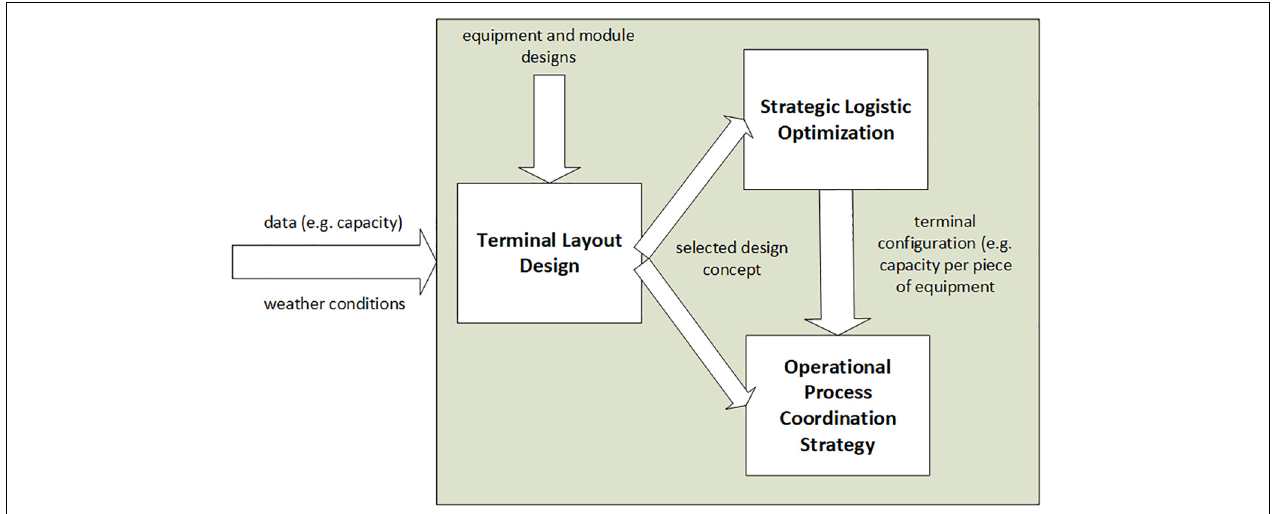
FIGURE 1 | A schematic representation of the connection among the three key design components.